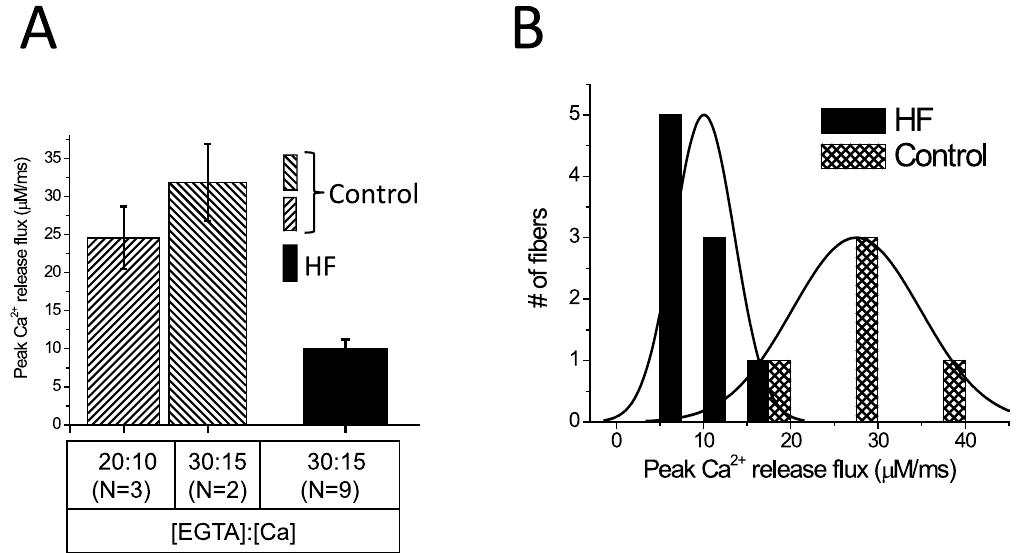
Figure 4. Average values and frequency distribution of peak Ca 2 + release flux values in fibers from healthy volunteers and HF patients. Panel A shows the mean ( 6 SD) of peak Ca 2 + flux in fibers of healthy volunteers (hatched) and of HF patients (black) equilibrated with internal solution containing either 30:15 or 20:10 EGTA:Ca. Panel B shows the frequency distribution of peak Ca 2 + release fluxes from all fibers in panel A. The binning width was 2.5 m M/ms and the lines correspond to fits of the data to standard normal distributions.